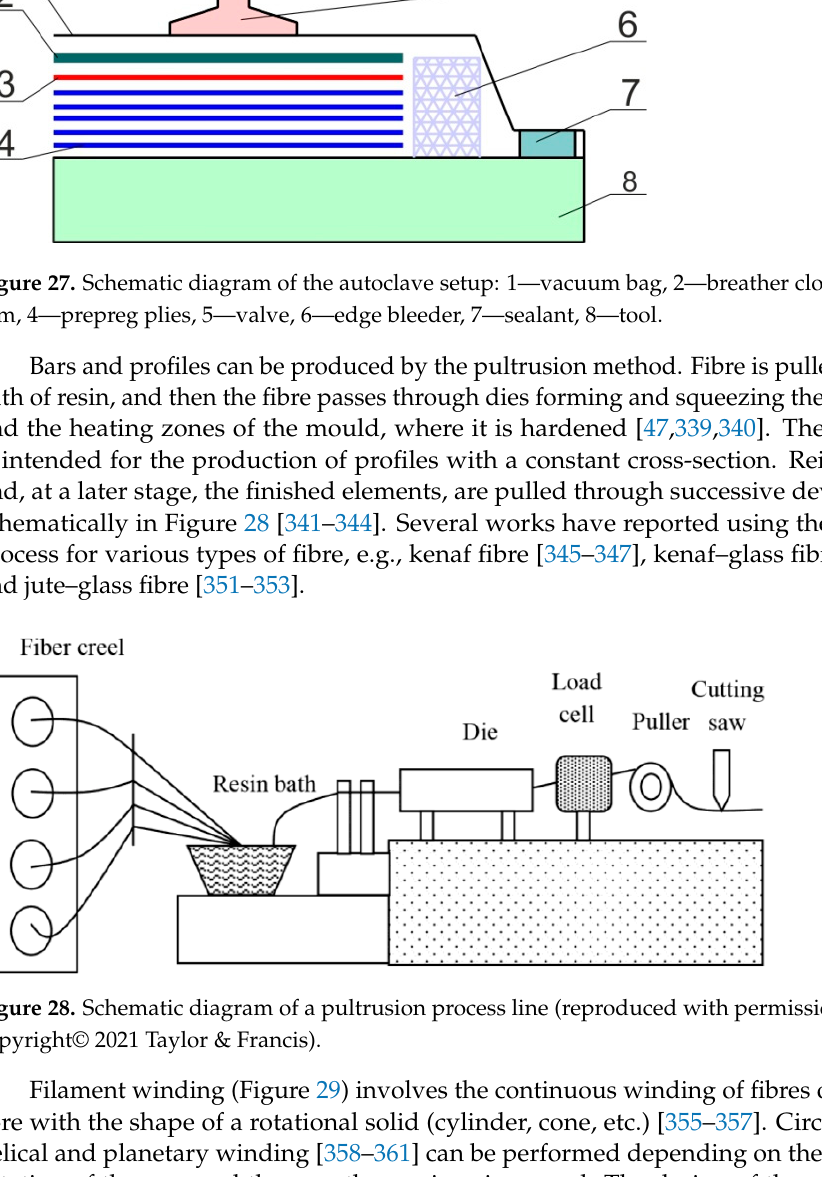
Figure 29. Schematic diagram of the filament winding process (reproduced with permission from [363]; copyright© 2021 Elsevier Science Ltd.). From the literature review, the reader should note that there remain two different approaches to obtaining the complicated shape of the FML part (Figure 30). In the first approach, the component layers of the material are first deformed, and then a laminate is fabricated based on the deformed layers. Forming single thin layers is costly and ex ‐ tremely demanding. A less costly alternative is to form the FMLs to be fabricated directly. In a later part of the article, methods of plastic working and laser forming for FML panels will be presented. Table 4 summarises the main advantages and disadvantages of lay ‐ up techniques of FML fabrication.